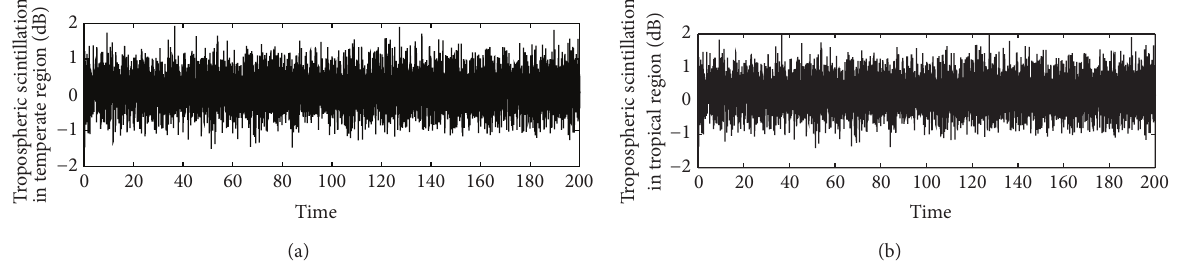
Figure 11: Modeled fluctuations caused by tropospheric scintillation: (a) temperate region and (b) tropical region LMS link scenarios.